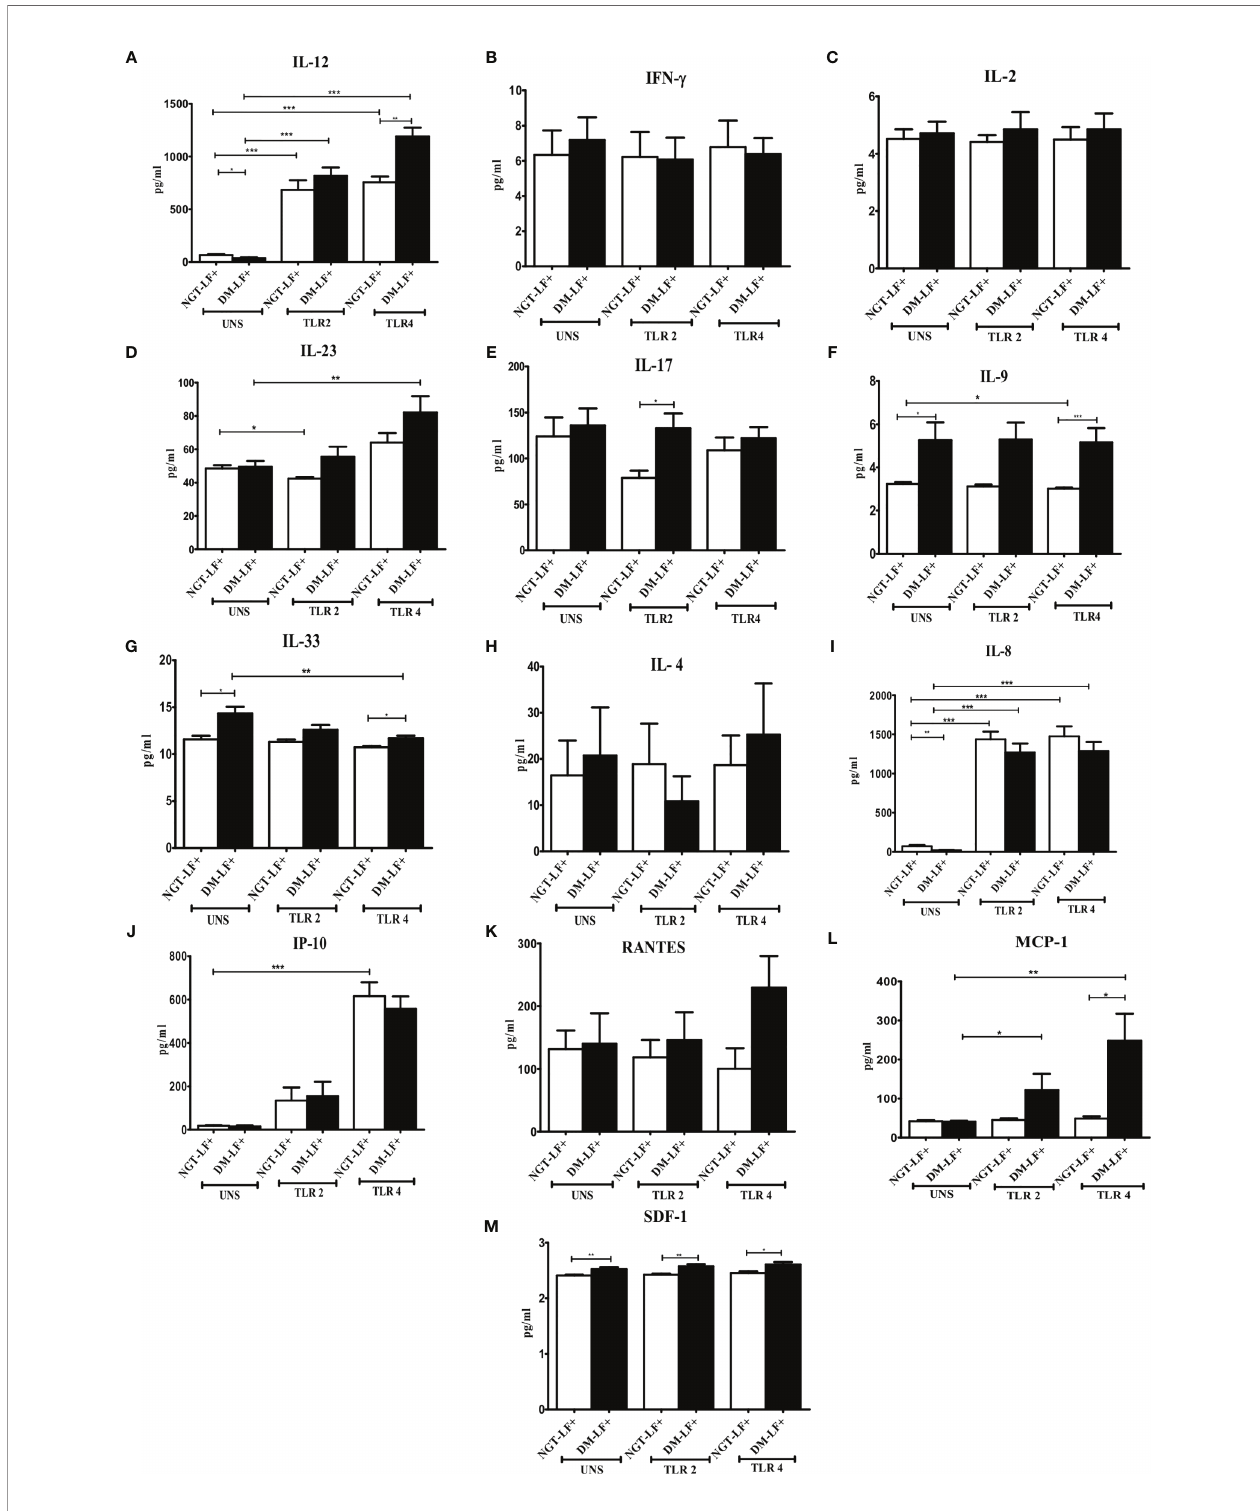
FIGURE 2 | Effect of diabetes on the TLR-induced secretion of adaptive immune cytokines and chemokines in LF+ subjects. Bar graph showing Unstimulated (UNS), TLR2-, and TLR4-induced secretion of IL-12 (A) , IFN- g (B) , IL-2 (C) , IL-23 (D) , IL-17 (E) , IL-9 (F) , IL-33 (G) , IL-4 (H) , IL-8 (I), IP-10 (J) , RANTES (K) , MCP-1 (L) , and SDF-1 (M) in the supernatants of blood cultures in NGT-LF+ and DM-LF+ subjects. Statistical signi fi cance was determined by non-parametric Mann – Whitney U test and p < 0.05 was considered signi fi cant. * p < 0.05; ** p < 0.01; *** p <